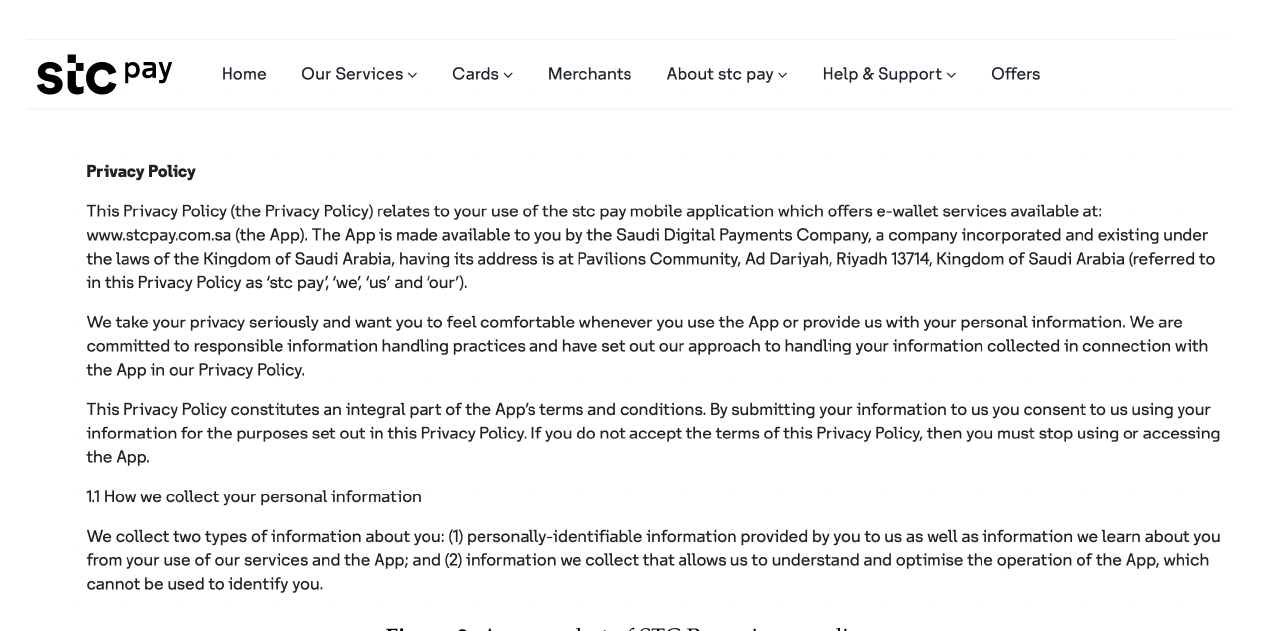
Figure 2. A screenshot of STC Pay privacy